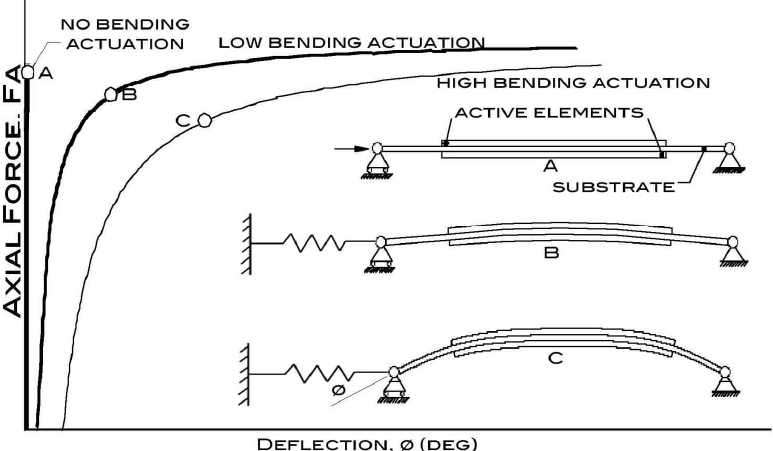
Figure 6. Basic Post-Buckled Precompressed Actuator Configuration under Low Axial Force (A), Moderate Axial Force (B), and High Axial Force (C) [34].